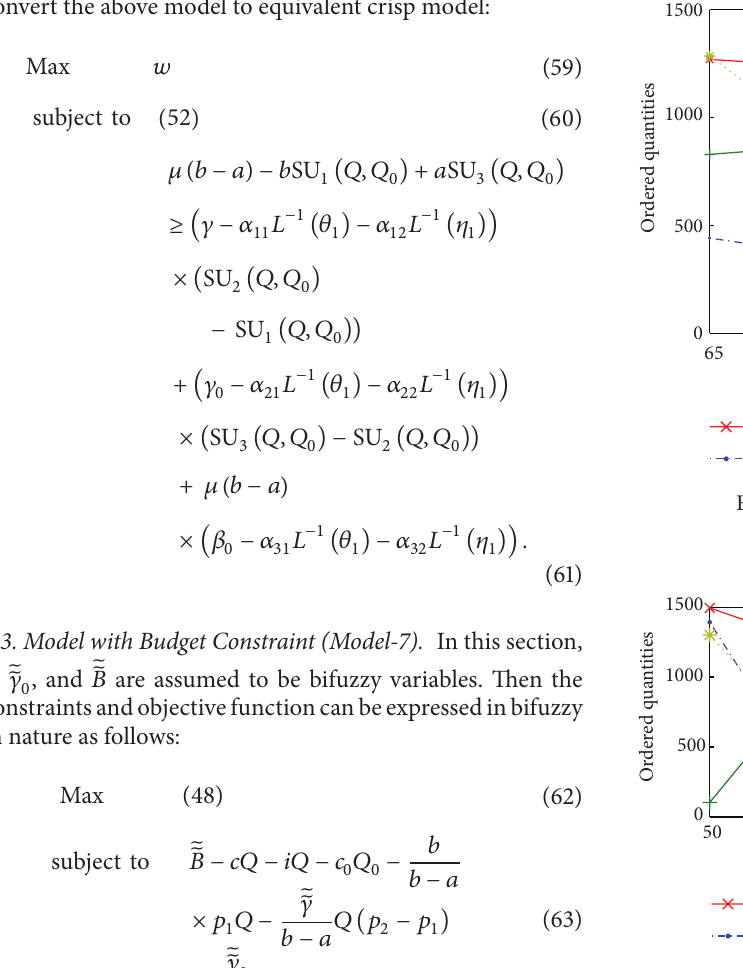
Figure 3: Effect of 𝛾 0 on the optimal